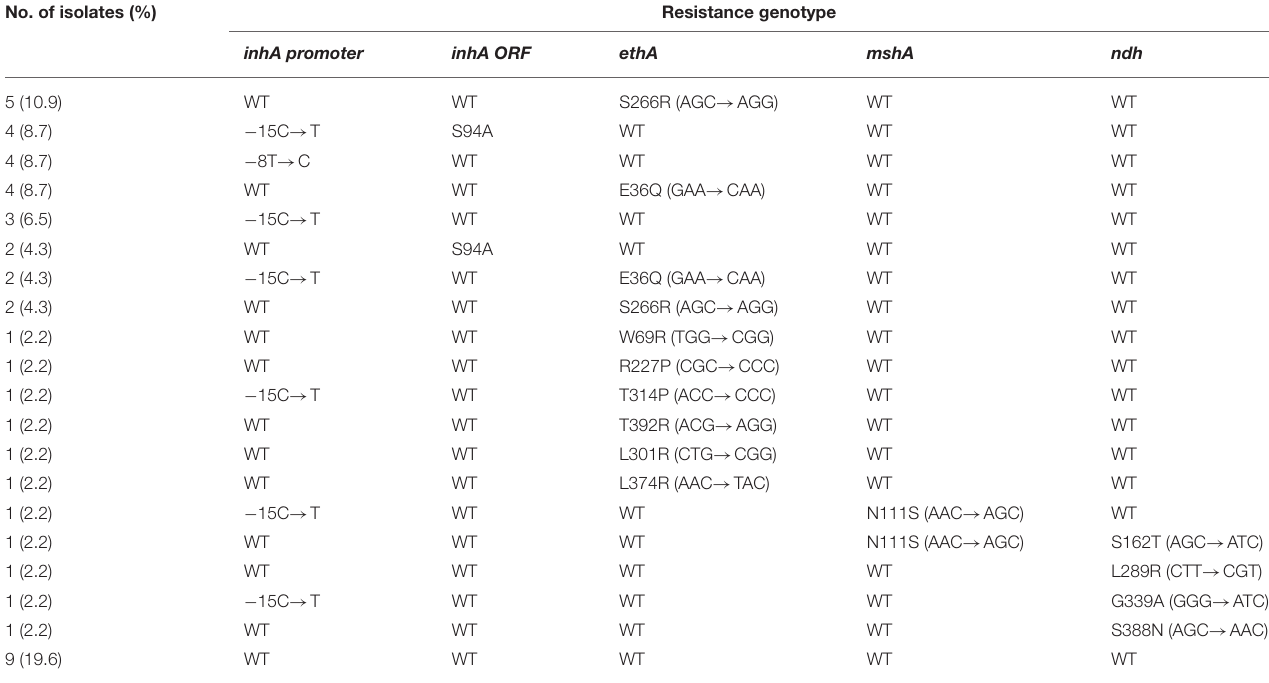
TABLE 5 | Mutations in inhA , ethA , mshA , and ndh in 46 PTH-resistant MTB isolates. No. of isolates (%)